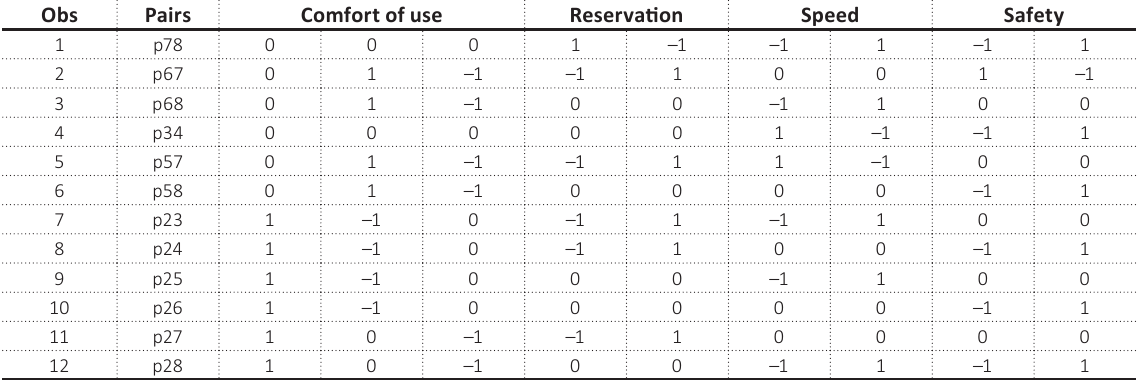
Table 4. Reduced pairs